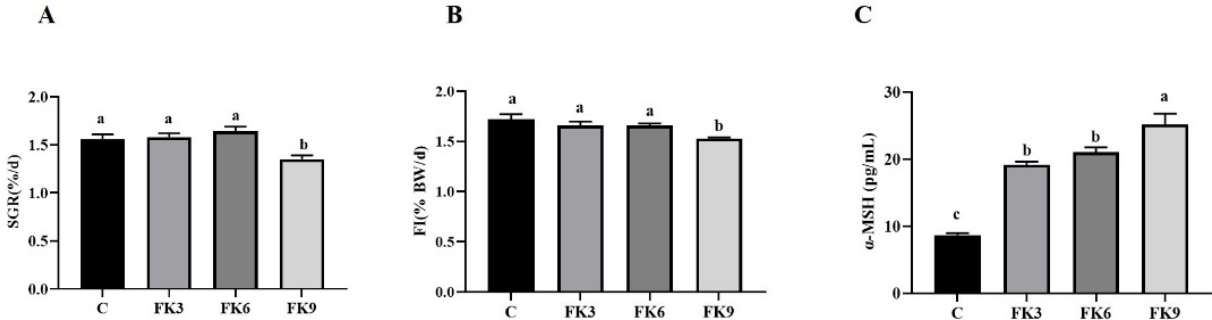
Figure 1. Specific growth rate (( A ), n = 4), Feed intake (( B ), n = 4), and plasma anorexia hormone α -MSH content (( C ), n = 8) of largemouth bass fed diets with various FK levels (mean ± SEM). SGR (specific growth rate, %/d) = 100 × [ln (final body weight) − ln (IBW)]/d]; FI (feed intake, %) = 100 × feed intake/[(W f + W i )/2]/days; W f : final total weight, W i : initial total weight. Superscript lowercase letters “a, b, c” indicate significant differences ( p < 0.05) among groups.